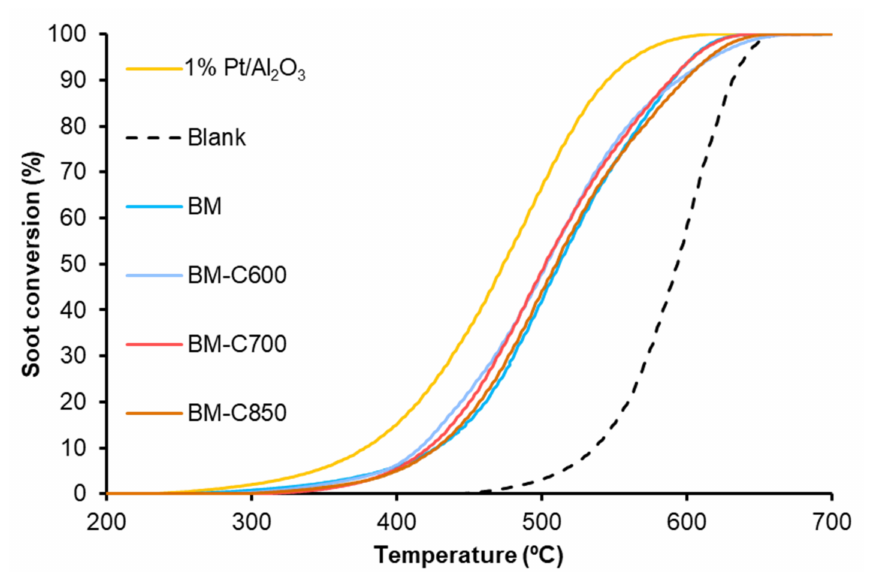
Figure 11. Soot oxidation profiles in NO X -TPR conditions of BM-CX series, and references (1% Pt/Al 2 O 3 and